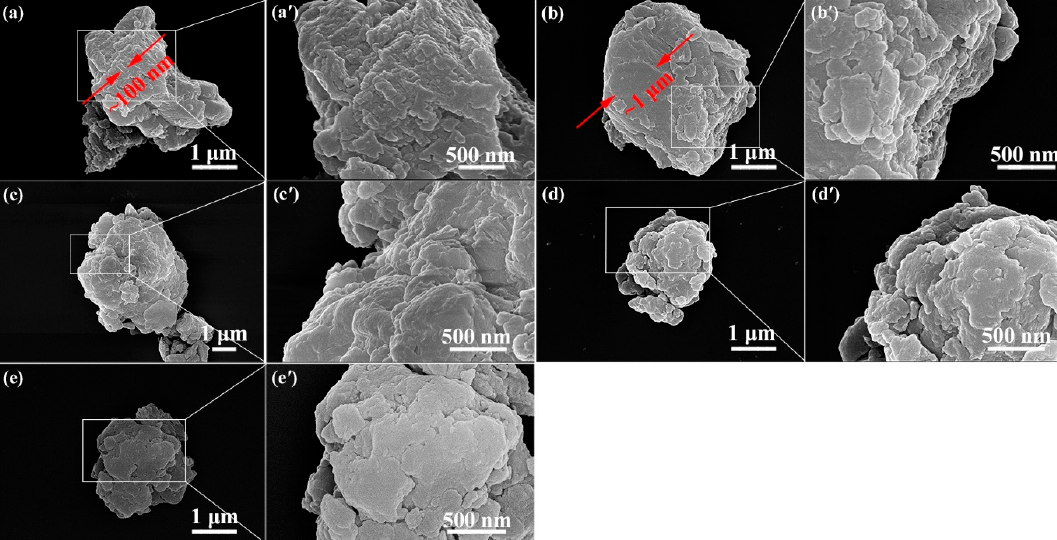
Figure 1. SEM images of ( a ) pure g-C 3 N 4 CN, ( b ) alkalized carbon nitride (ACNK), ( c ) Fe 3+ -doped alkalized carbon nitride (AKCN-0.006Fe), ( d ) AKCN-0.010Fe, and ( e ) AKCN-0.014Fe (( a ′ – e ′ ) are the corresponding local